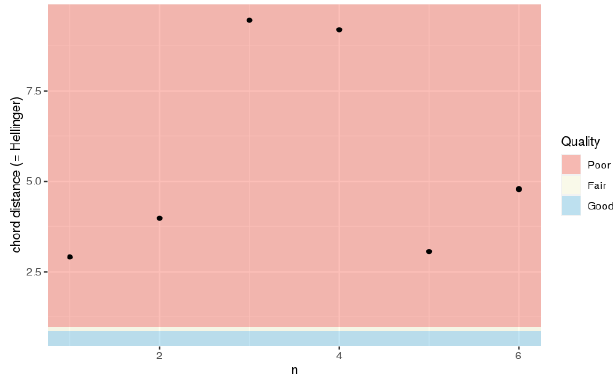
Figure A3. Analogue distance of a subset of the sediment surface samples (PS97/045-1, 044-1, 042-1, 094-1, 015-2 and 020-1) to the nearest plankton samples (PS97/043-2, 040-1, 034-2, 016-1 and 029-1, Saavedra-Pellitero et al., 2019) provides poor results. Calcu- lated with ggpalaeo version 0.0.0.9005 (Telford,